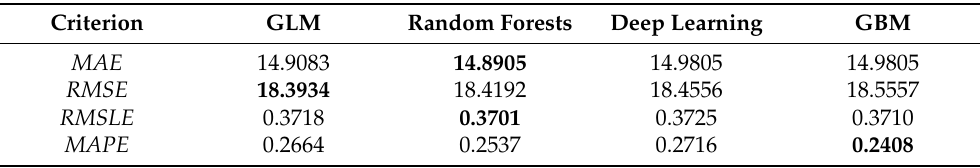
Table 3. Regression metrics for each machine learning